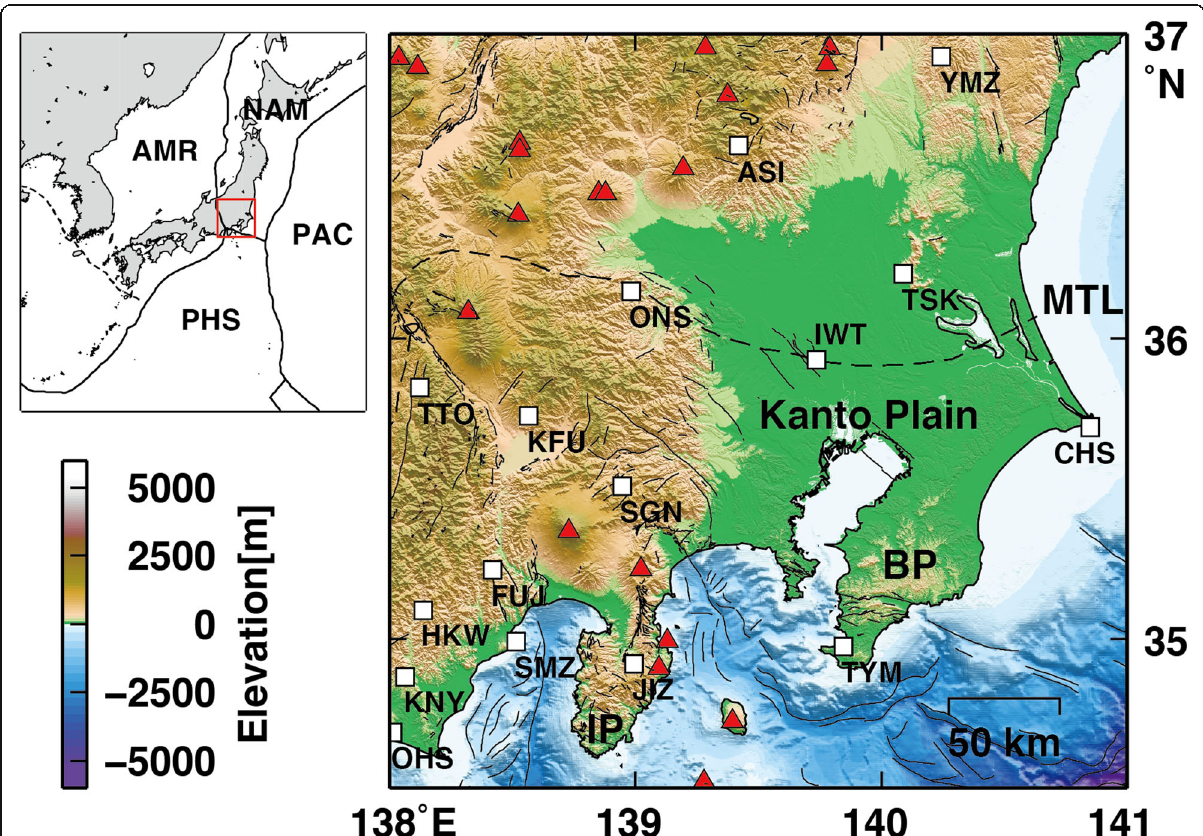
Fig. 1 Distribution of tectonic plates and topography of the study area. Open squares indicate the NIED F-net stations used in the present study. Red triangles denote active volcanoes. Thin black lines and the broken line denote active faults and the Median Tectonic Line (MTL), respectively. AMR, NAM, PAC, and PHS in the left figure indicate the Amur, North America, Pacific, and Philippine Sea plates, respectively. BP and IP in the right figure indicate the Boso and Izu